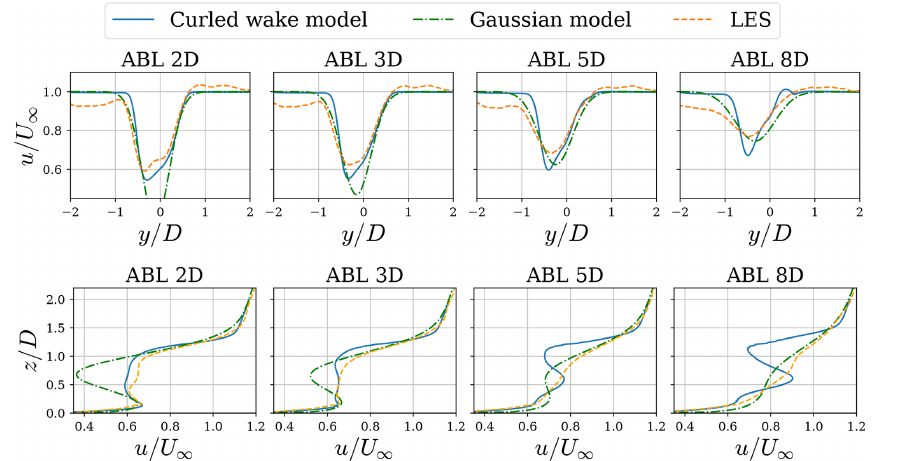
Figure 8. Plots across horizontal and vertical lines passing through the center of the rotor for a LES using a neutral ABL simulation of a turbine in 20 ◦ yaw using an ALM and the curled wake model.